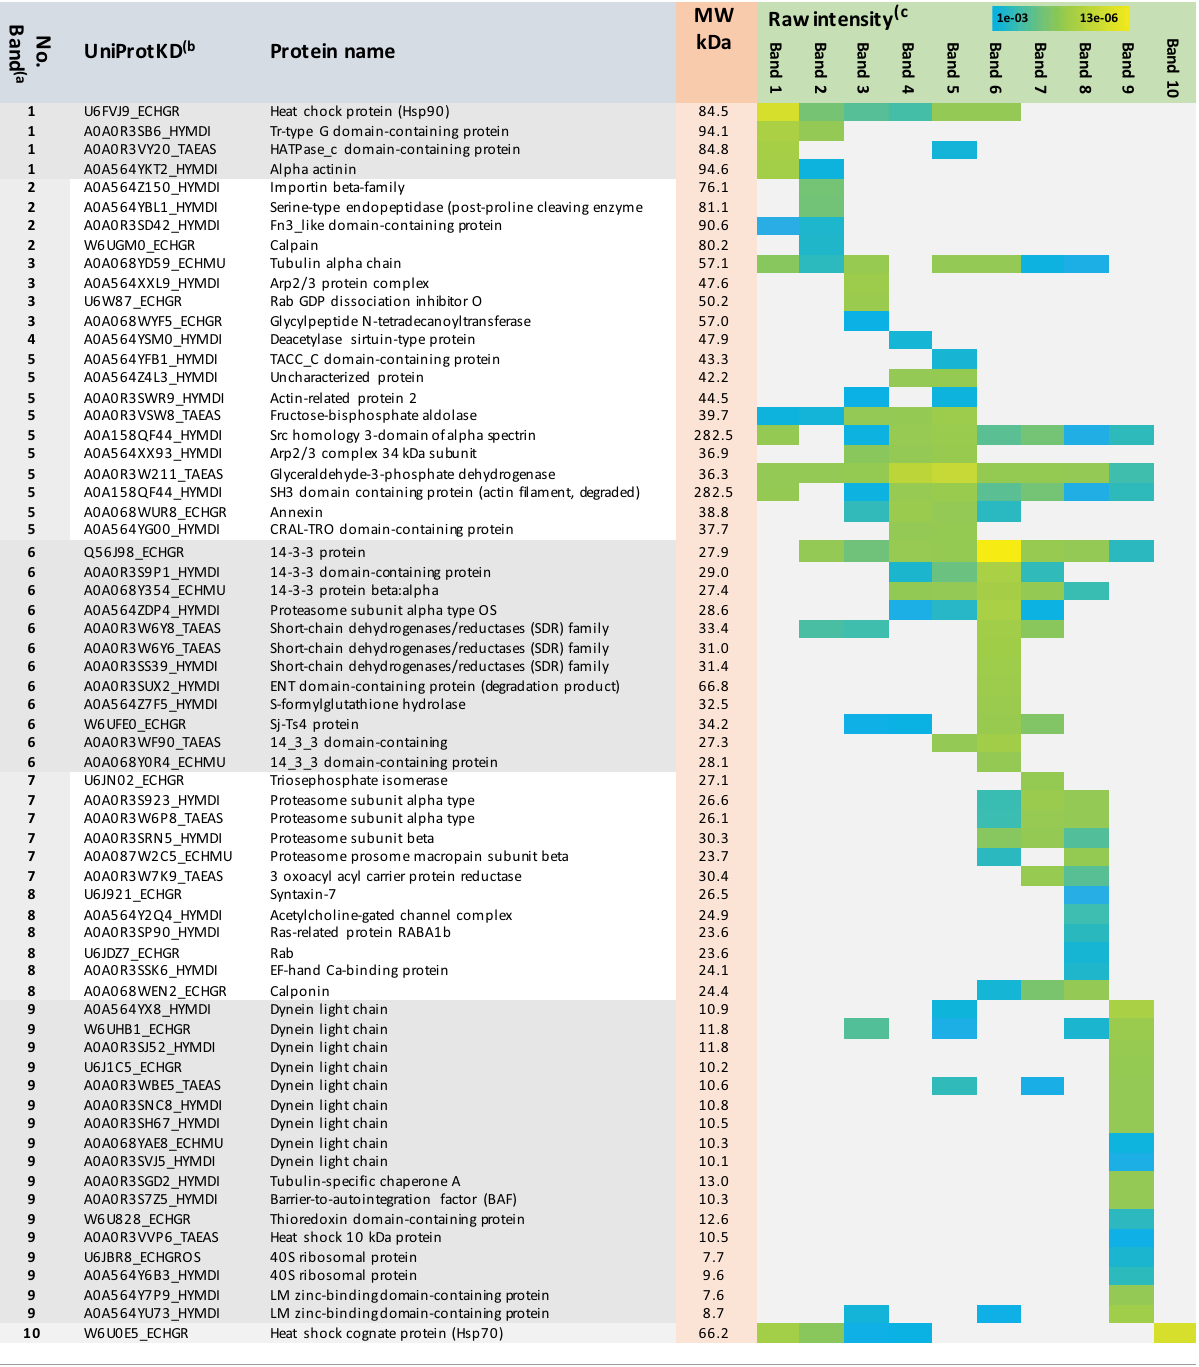
TABLE 1 List of the E/S protein bands cross-reacting with the anti- A. perfoliata and infection-naïve antibodies.